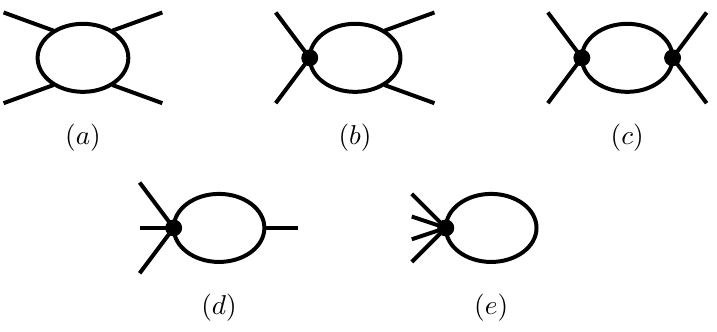
Figure 1 . ( a ) Box diagram in supergravity; ( b ) Triangle diagram with one r 4 p +6 q R 4 quartic vertex; ( c ) Bubble diagram with two quartic vertices; ( d ) Bubble diagram with one quintic and one cubic vertex; ( e ) Tadpole diagram with one sextic